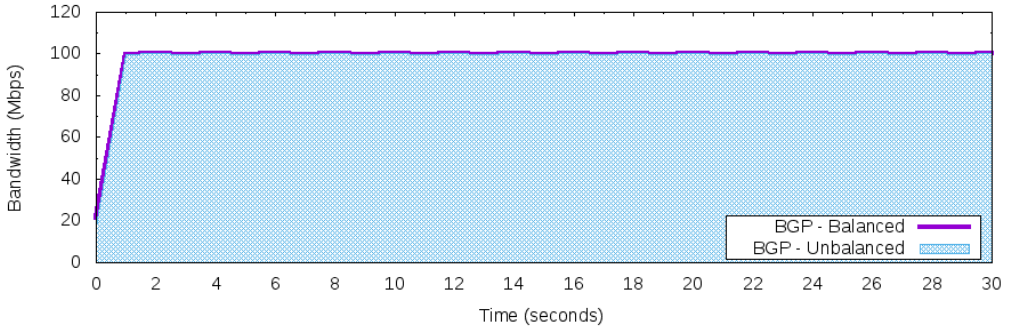
Figure 6. BGP behavior for network traffic to the server 192.168.0.1/24 in AS